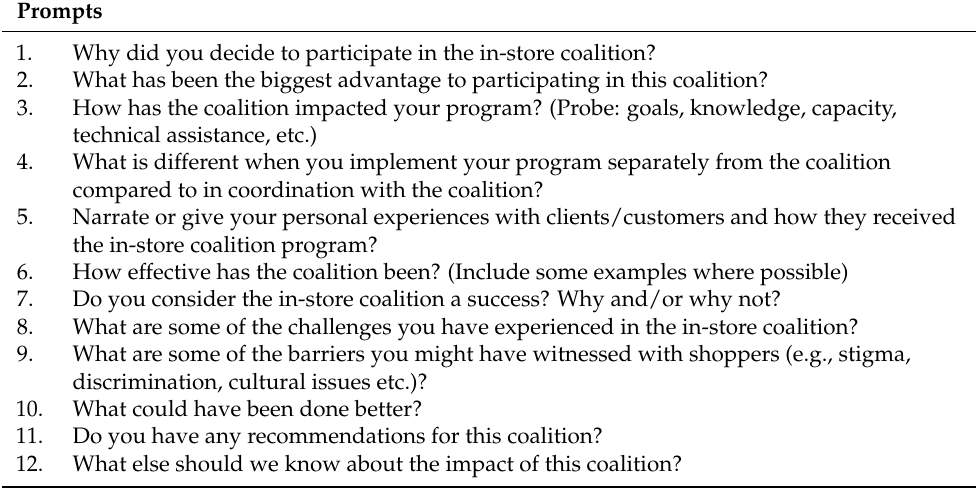
Table 2. IPOC Member Reflection